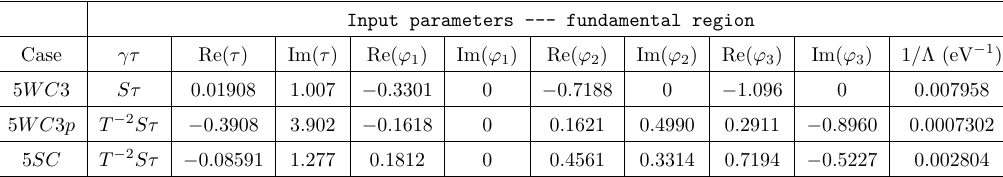
Table 10 . Parameters (cid:28) and ’ in the fundamental region for level 5